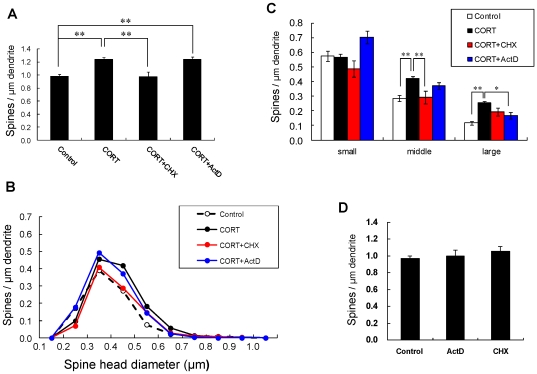
Effects of inhibitors for protein and mRNA synthesis on changes in the density and morphology of spines by CORT.(A) Total spine density. Effect of inhibitors for protein or mRNA synthesis in the presence of CORT on CA1 neurons. A 1 h treatment in ACSF without drugs (Control), with 1 µM CORT (CORT), with 1 µM CORT and 20 µM cycloheximide (CORT + CHX), and with 1 µM CORT and 4 µM actinomycin D (CORT + ActD). (B) Histogram of spine head diameters. Abbreviations are same as in (A). Control (open circle), CORT (closed black circle), CORT + CHX (closed red circle), and CORT + ActD (closed blue circle). (C) Density of three subtypes of spines. Abbreviations are same as in (A). From left to right, small-head spines (small), middle-head spines (middle), and large-head spines (large). ACSF without drugs (open column), CORT (black column), CORT + CHX (red column), and CORT + ActD (blue column). Vertical axis is the average number of spines per 1 µm of dendrite. Statistical significance is calculated against CORT treated group in each spine subtypes and comparisons reached significance are indicated by stars. (D) No effect of inhibitors alone for protein and mRNA synthesis on the total spine density in CA1 neurons. Abbreviations are the same as in (A). Vertical axis is the average number of spines per 1 µm of dendrite. In (A) and (C), results are reported as mean ± SEM. In (A) and (C), the significance of CORT or drug effect was examined using the Tukey–Kramer post hoc multiple comparisons test when one way ANOVA tests yielded P<0.05. *P<0.05, **P<0.01. For each drug treatment, we investigated 3 rats, 6 slices, 12 neurons, 24 dendrites and 1100–1800 spines, except for 1 µM CORT which consists of 10 rats, 28 slices, 56 neurons, 113 dendrites and approx. 8000 spines. For control, we used 5 rats, 8 slices, 16 neurons, 31 dendrites and approx. 1700 spines.